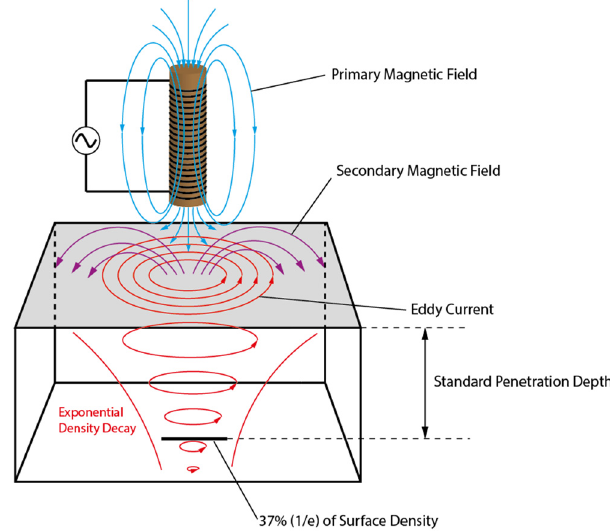
Figure 10. Schematic of the generation and penetration depth of eddy current.